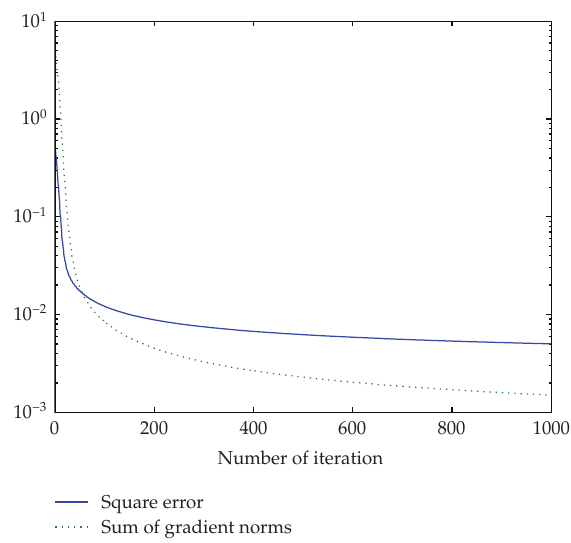
Figure 1: Convergence behavior of OSCG algorithm for solving XOR problem (cid:4) sum of gradient norms (cid:6) (cid:12) ∂E (cid:4) w n (cid:5) /∂ w R (cid:12) (cid:7) (cid:12) ∂E (cid:4) w n (cid:5) /∂ w I (cid:12) (cid:5)